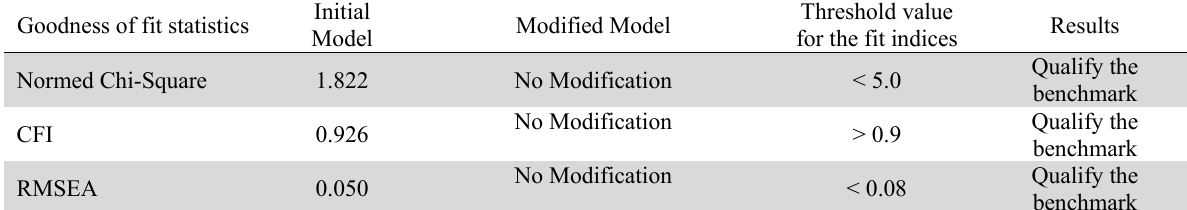
Fig. 2. Confirmatory factor analysis (CFA) of overall Measurement Model CFA results for Overall Measurement